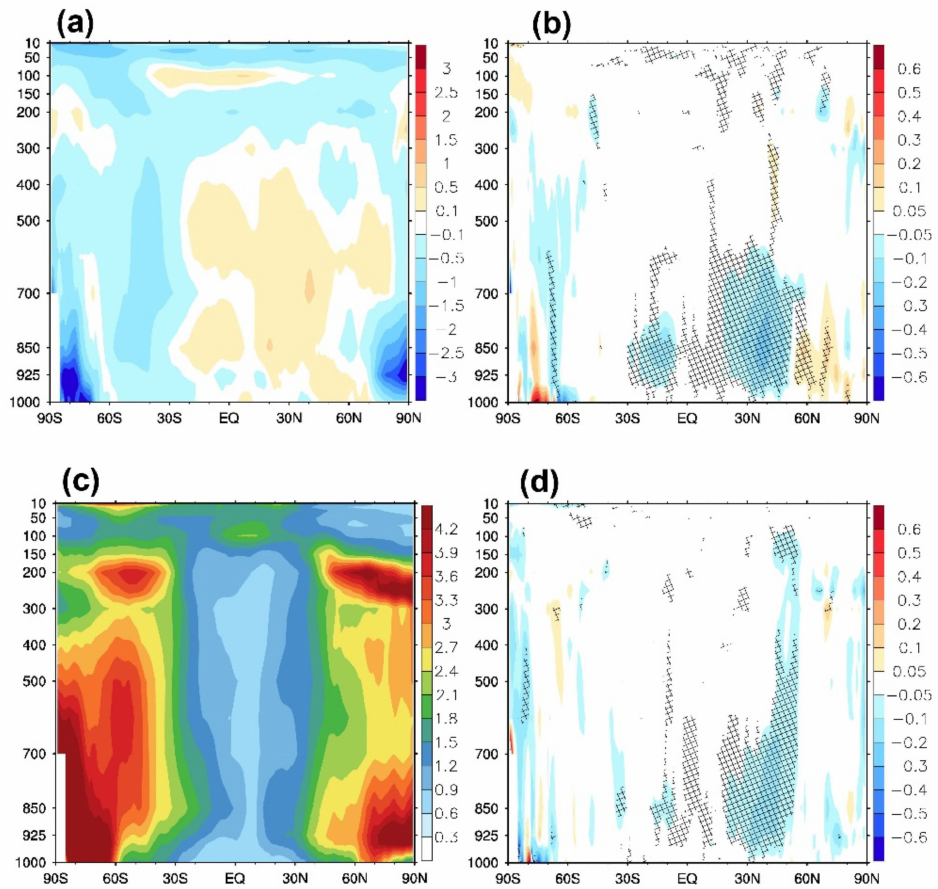
Figure 11. ( a ) Biases and ( c ) RMSEs of the zonal mean air temperature in the CTL against the ERA5 reanalysis, and ( b ) differences in the biases and ( d ) RMSEs between the EXP and CTL over the period of 1 July 2019 to 10 August 2019 for a five-day forecast. The hatched regions indicate a difference significant at the 95% confidence level.